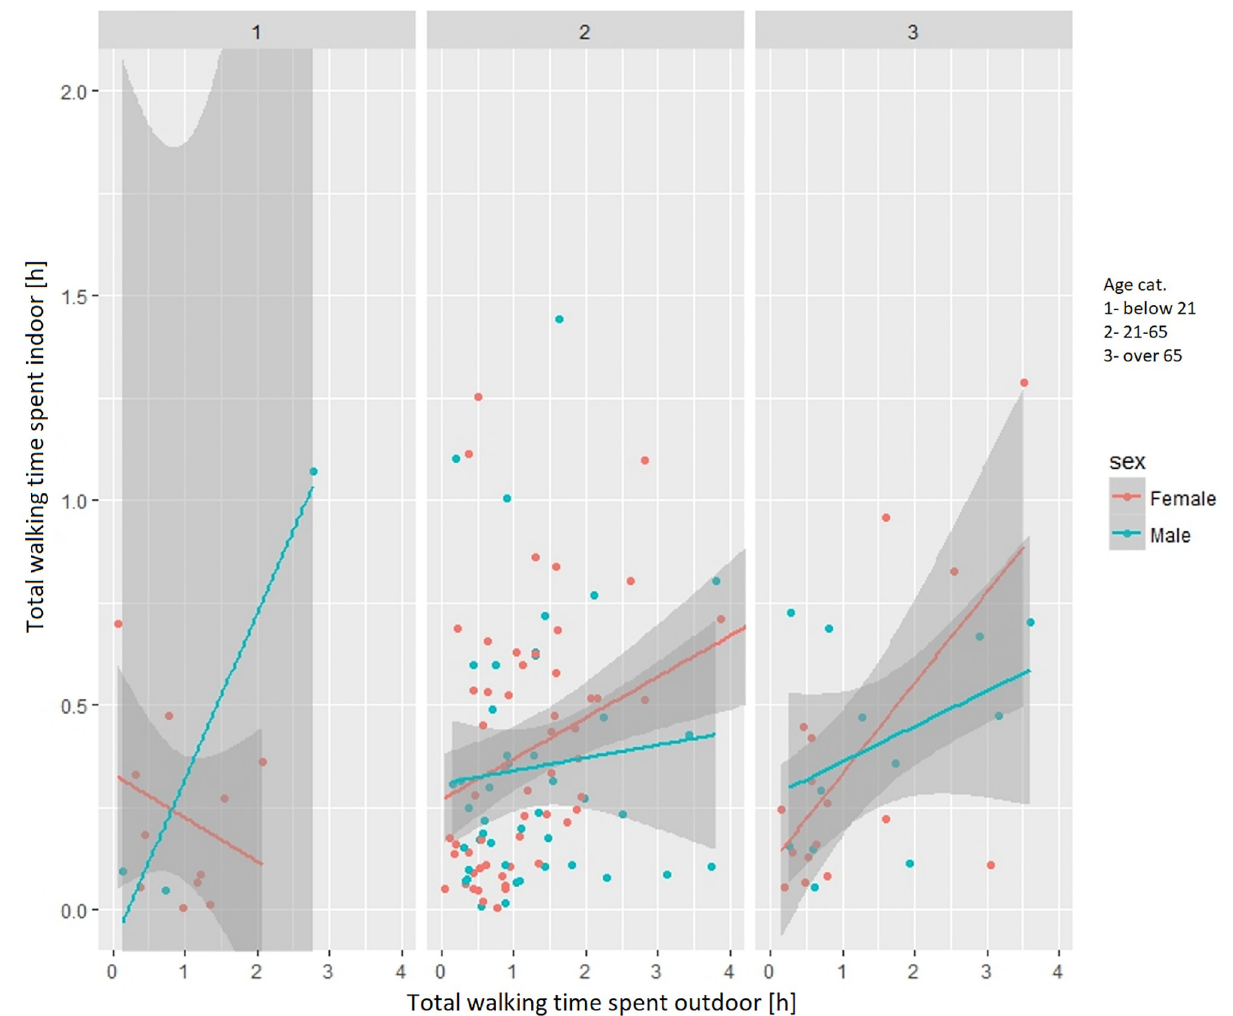
Fig 9. Relationship between indoor and outdoor walking for different genders and age